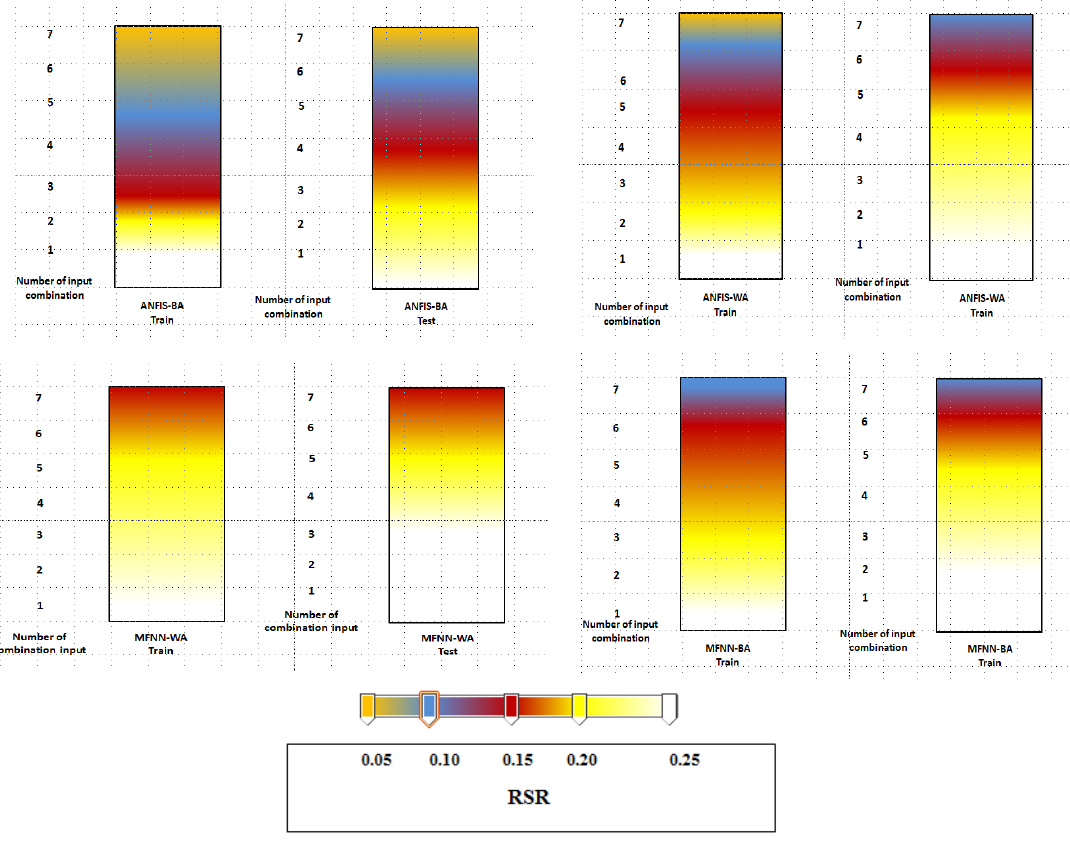
Figure 11. Standard deviation ratio (RSR) computations for different models.